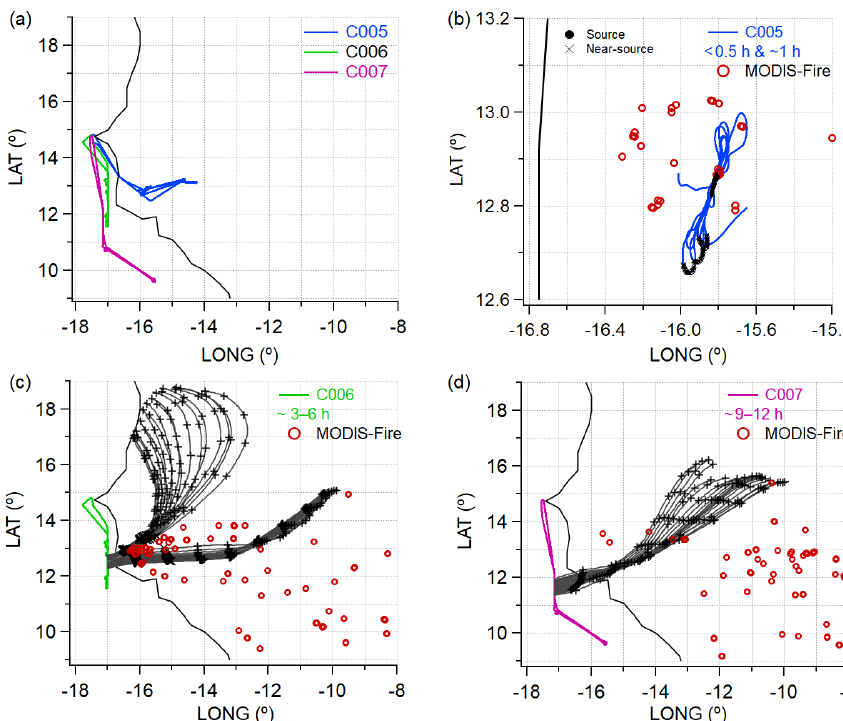
Figure 1. (a) Tracks of the flights (labelled from C005 to C007) used in this study. (b) The selected fresh and near-source plumes, with the spatial distribution of MODIS-detected fires during flight C005. (c,d) 1d back trajectory of sampled smoke selected from flights C006 (c) and C007 (d) , marked (black crosses) with every 3h increment. The MODIS-detected fires are also shown in the plots (as observed 3–12h before the sampling